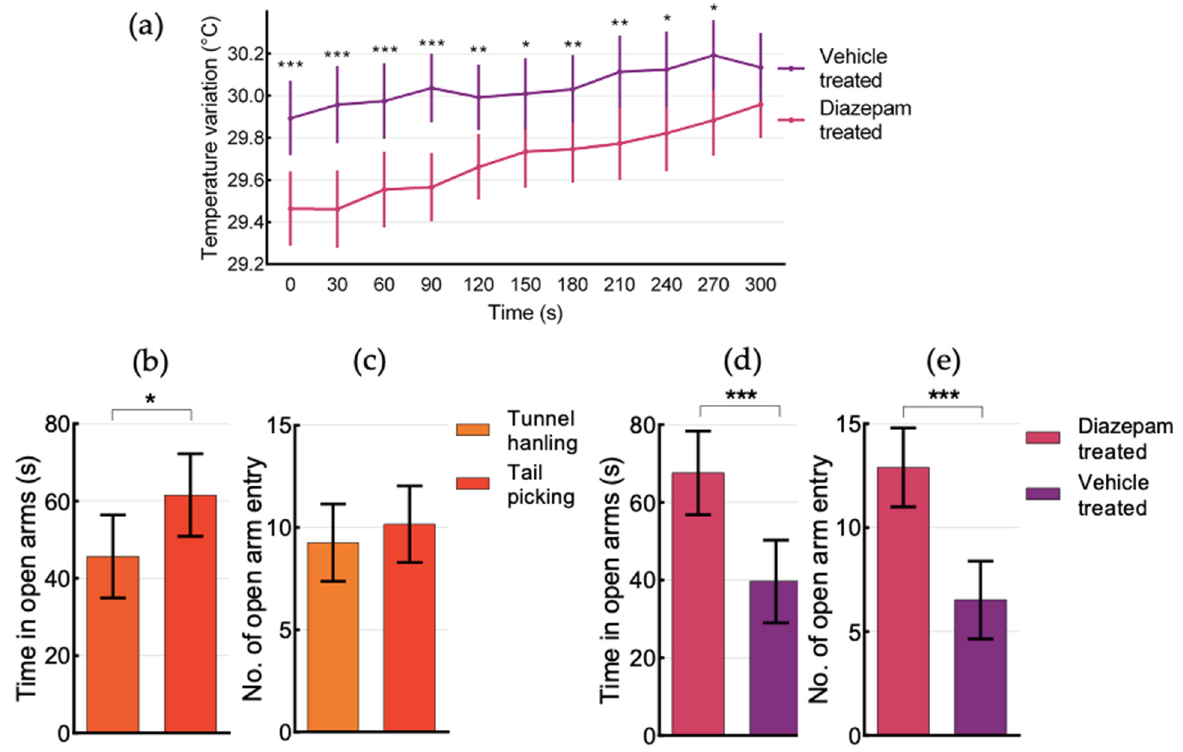
Figure 6. Elevated Plus Maze (EPM) differences for ( a ) T body between diazepam- and vehicle-treated mice ( b ) time spent in open arms and ( c ) number of open arm entries between tunnel-handled and tail-picked mice, ( d ) time spent in open arms and ( e ) number of open arm entries between diazepam- and vehicle-treated mice. Error bars represent 95% CI, * p < 0.05, ** p < 0.01, *** p < 0.001.